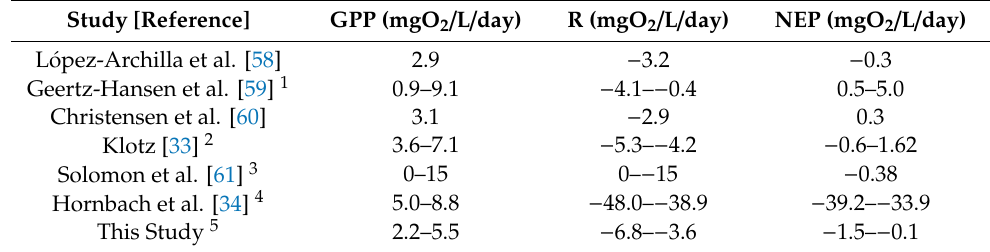
Table 5. Values of GPP, R and NEP from a number of published studies. Study